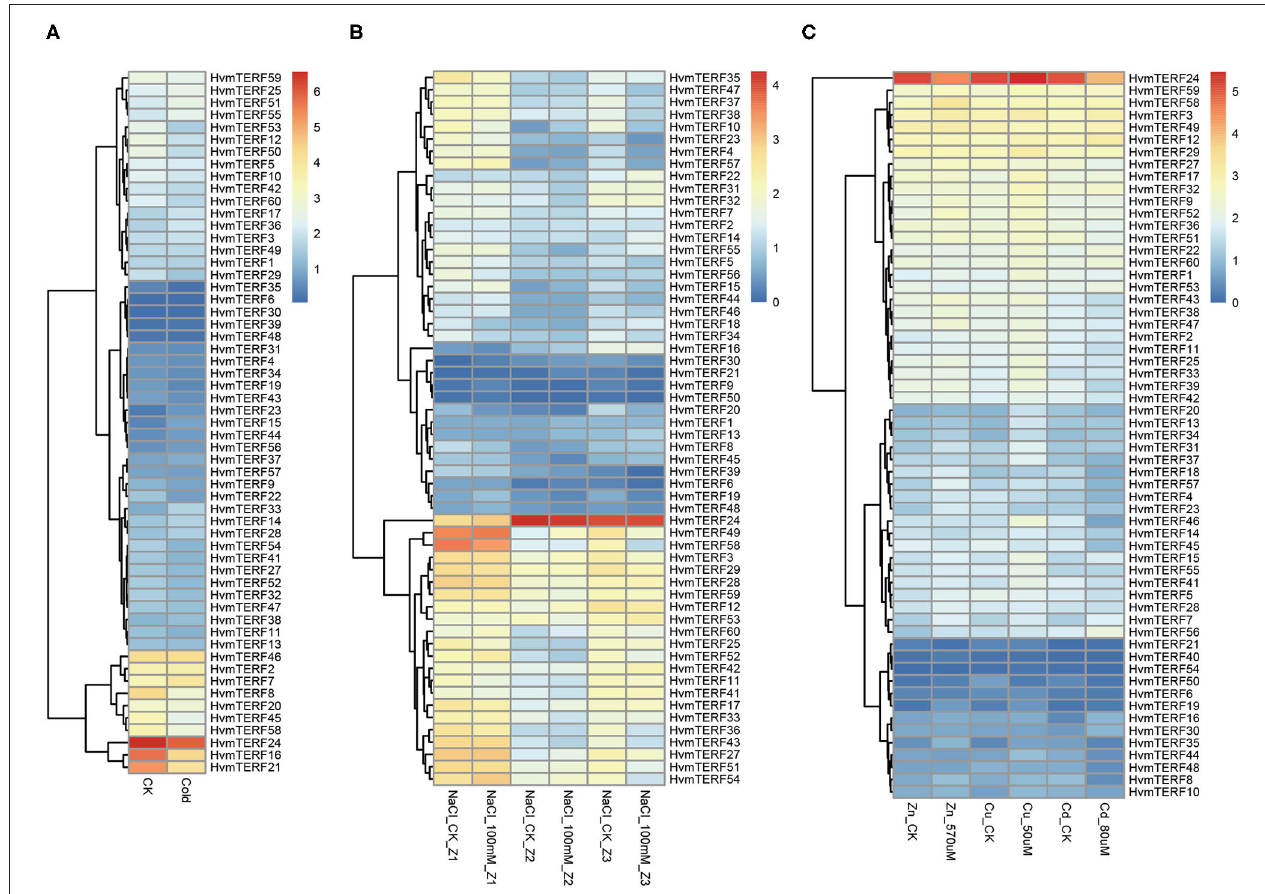
FIGURE 6 | Expression profiles of mTERF genes under five stress conditions. (A) cold stress; (B) salt stress; (C) zinc, copper, and cadmium